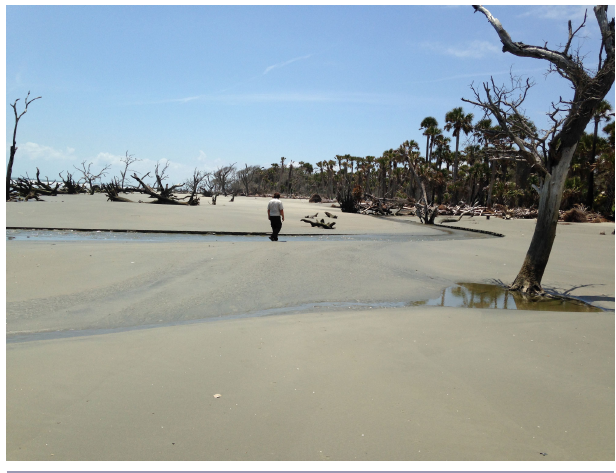
Fig. 5 . A refuge biologist surveys the effect of sea-level rise at the “boneyard” on Cape Romain National Wildlife Refuge in South Carolina (photo credit: F. A.